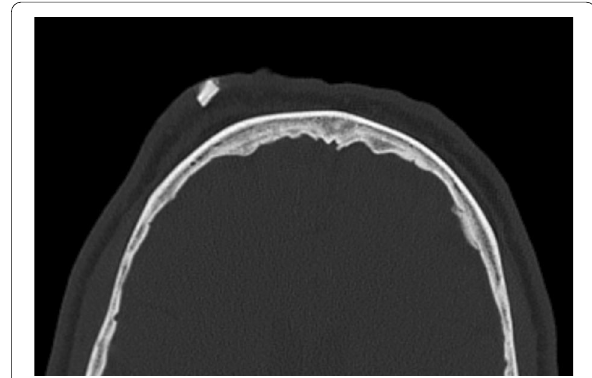
Fig. 14 Stone. Axial CT showing a hyperdense structure in the subcutaneous tissues in the right frontal area